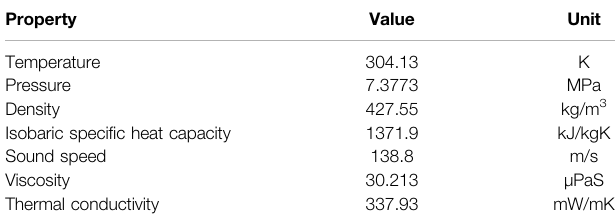
TABLE 1 | Thermophysical properties of CO 2 at the critical